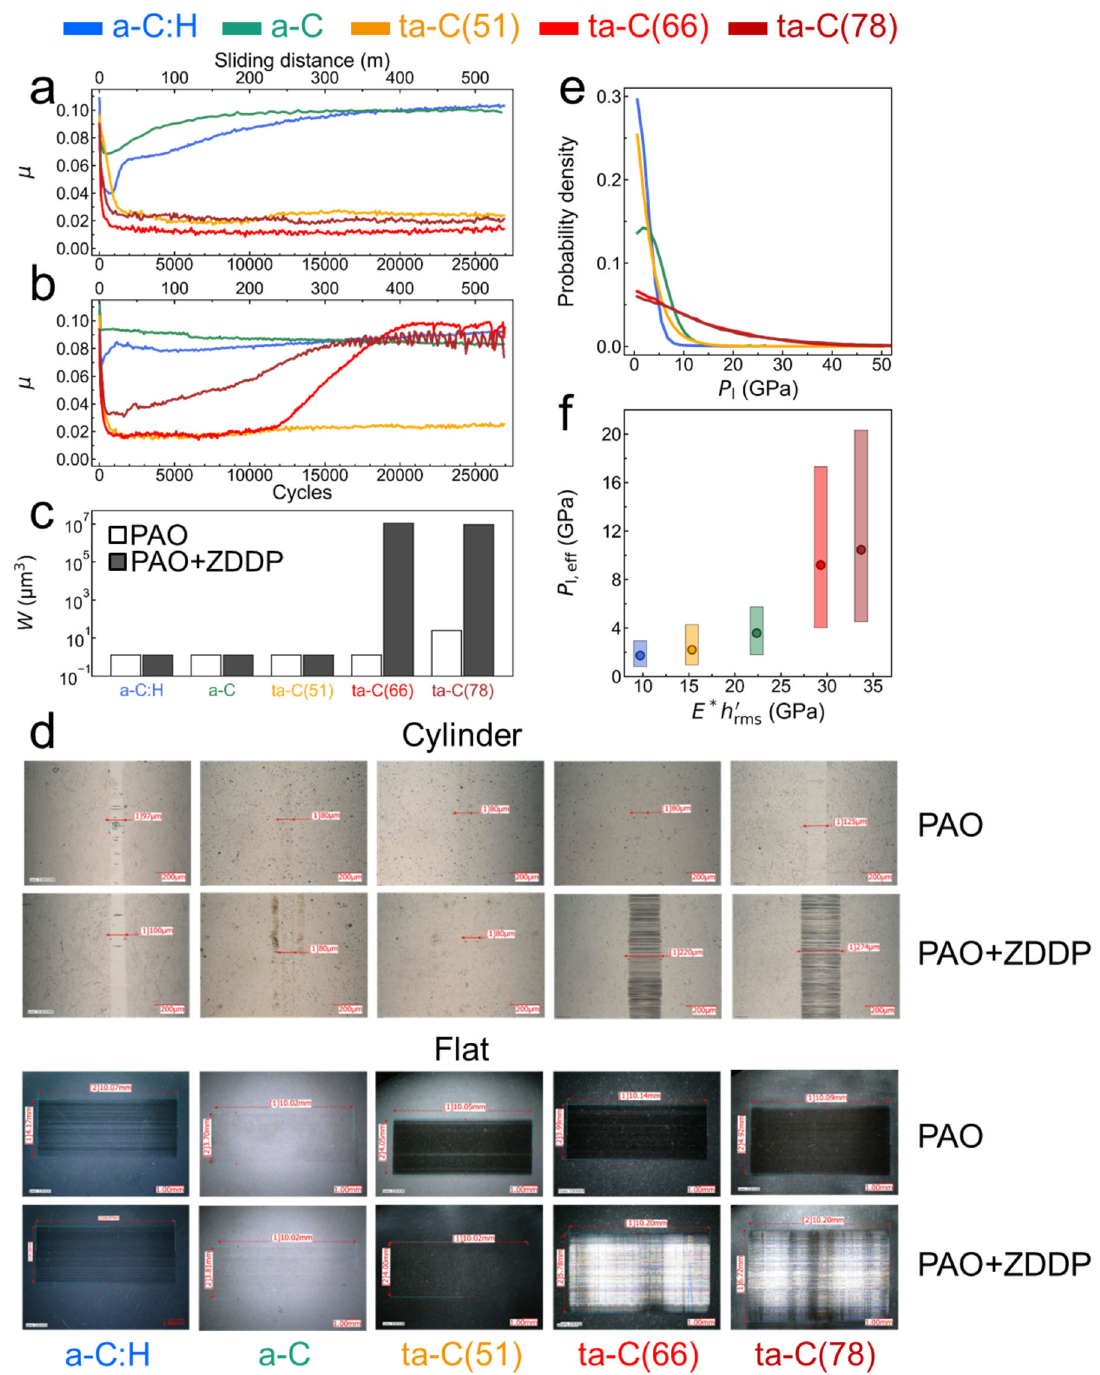
Fig. 1 Reciprocating sliding tests of fi ve self-mated DLC tribopairs. Friction curves in pure PAO-4 base oil ( a ) and a mixture of PAO-4 and 1 wt% ZDDP ( b ) for a-C:H (blue), a-C (green), ta-C(51) (orange), ta-C(66) (red) and ta-C(78) (brown). c Composite wear volumes measured on the discs and cylinders by optical interferometry and d optical images of the wear tracks of the DLC-coated cylinders and discs after sliding. e Local contact pressure distributions calculated from contact mechanics calculations using AFM topographies measured inside the wear track after running-in (2000 cycles) with a scan area of 20 × 20 µ m 2 . f Effective local contact pressure P l ; eff as a function of E (cid:4) h 0 , where E * is the contact modulus and h 0 is the combined root-mean-square rms rms slope between two DLC surfaces. P l ; eff is de fi ned as the median over all nonzero P l values and is obtained from a numerical boundary element solution of two experimental DLC topographies under a normal pressure of 210 MPa. Filled circles (with the same colour coding as in a and b mark the material parameter E (cid:4) h 0 of each DLC coating. The boxes represent the range of the P l distribution (limited by the 25th and 75th rms